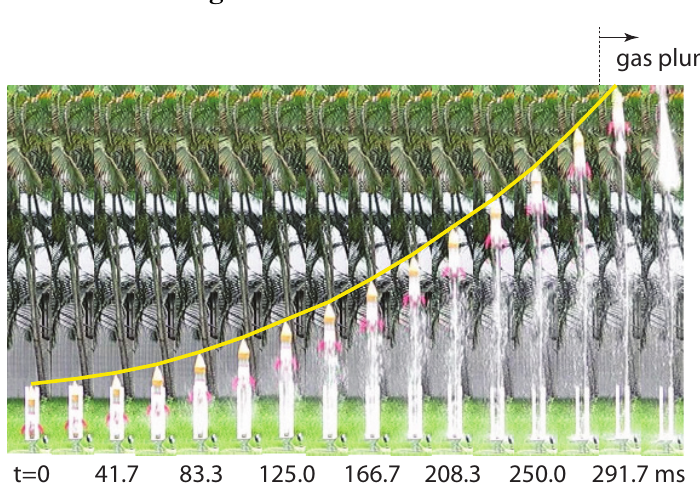
Figure 2. Water rocket lift-off.